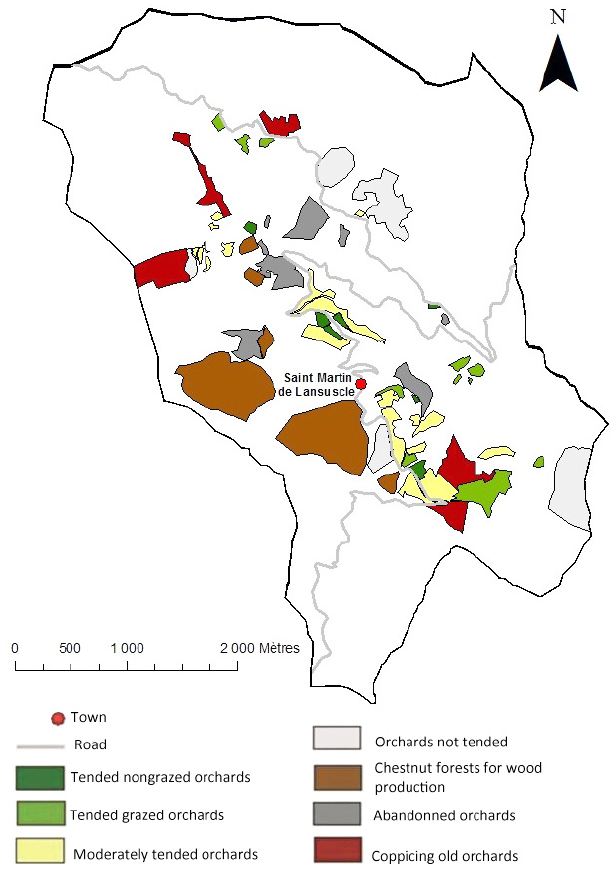
Fig. 5 . Distribution of different types of chestnut ( Castanea sativa Mill.) rural forests at the landscape level in the rural District of Saint Martin de Lansuscle, Languedoc- Roussillon.